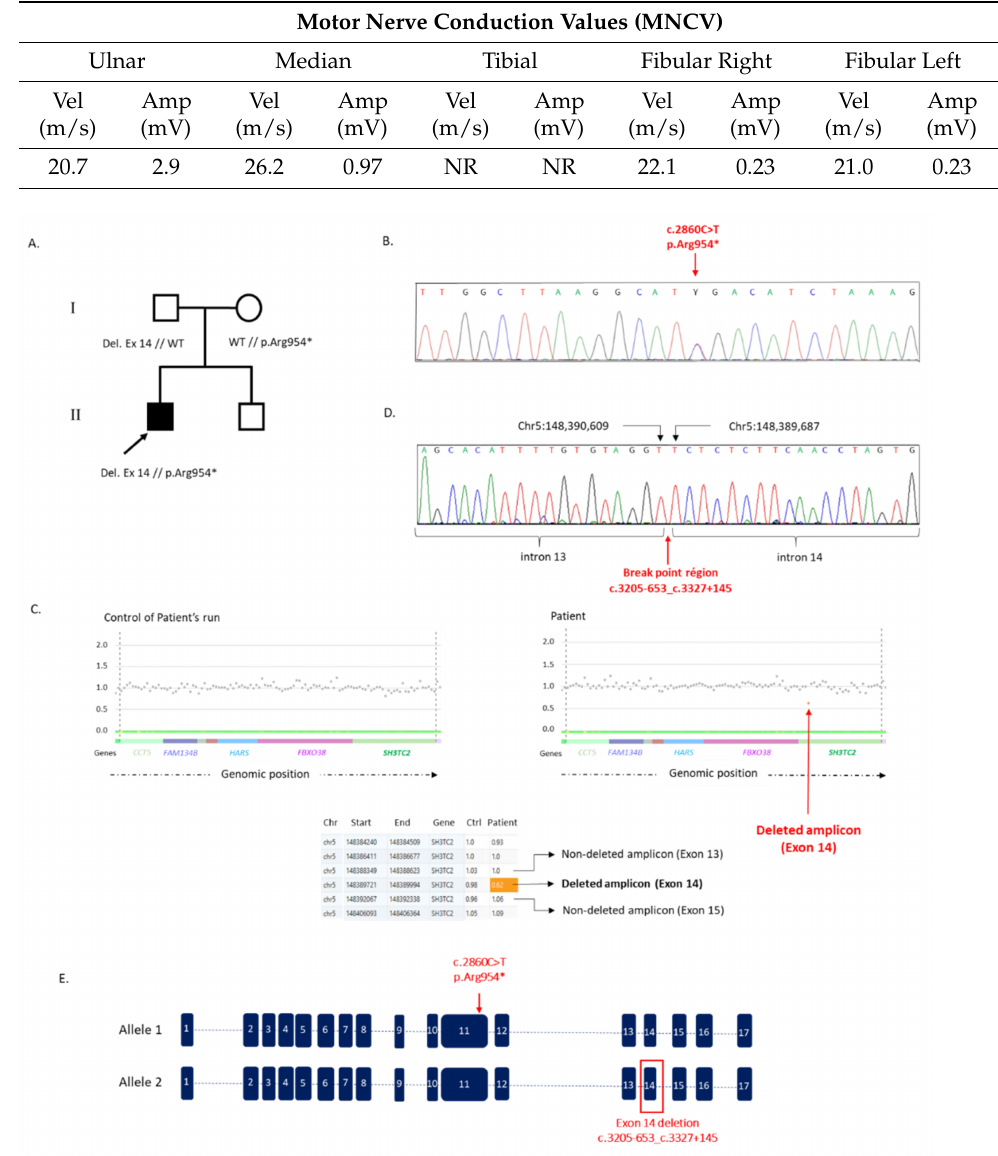
Figure 1. Family’s pedigree, analysis of SH3TC2 by CovCopCan and verification of mutations by Sanger sequencing. ( A ) Family’s pedigree. WT indicates the normal SH3TC2 allele, “p.Arg954*”, the allele presenting the missense mutation c.2860C > T leading to a premature terminal codon and Del ex14, the allele with SH3TC2 deletion corresponding to c.3205-653_c.3327 + 145 del including exon 14. ( B ) Sanger sequencing of the first mutation c.2860C > T, p.Arg954* at the heterozygous state. ( C ) Graphical representation and table extracted from CovCopCan analysis for the patient and for a control (Ctrl). In the graphical representation, each dot represents an amplicon. Normal amplicons (in gray) have values around 1, whereas deleted amplicons (in orange) have values around 0.5. Deleted amplicon corresponds to SH3TC2 exon 14. Start and end on the table correspond to the chromosomic positions of amplicons. ( D ) Detection of breakpoints in SH3TC2 by Sanger sequencing. The breakpoints were localized in position Chr5:148,390,609 in intron 13 and in position Chr5: 148,389,687 in intron 14. ( E ) Schematic overview of SH2TC2 and variations localization. Blue boxes correspond to SH3TC2